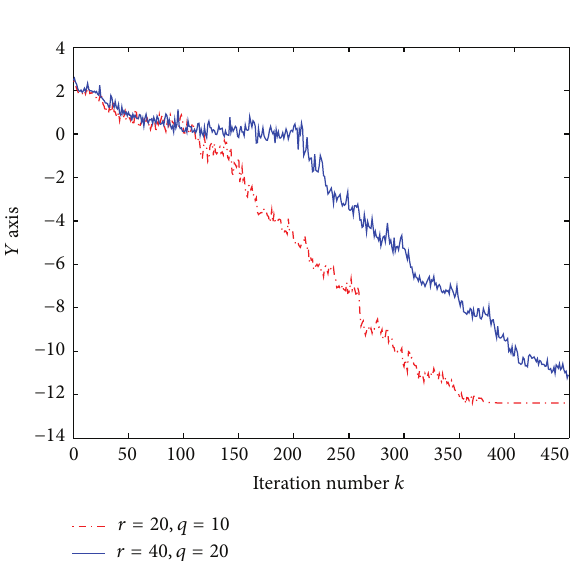
Figure 2: The convergence curve of the Frobenius norm of the residual.